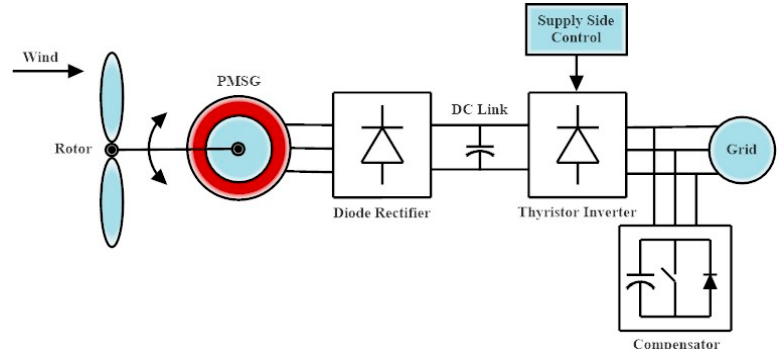
Figure 14. Thyristor grid-side converter.